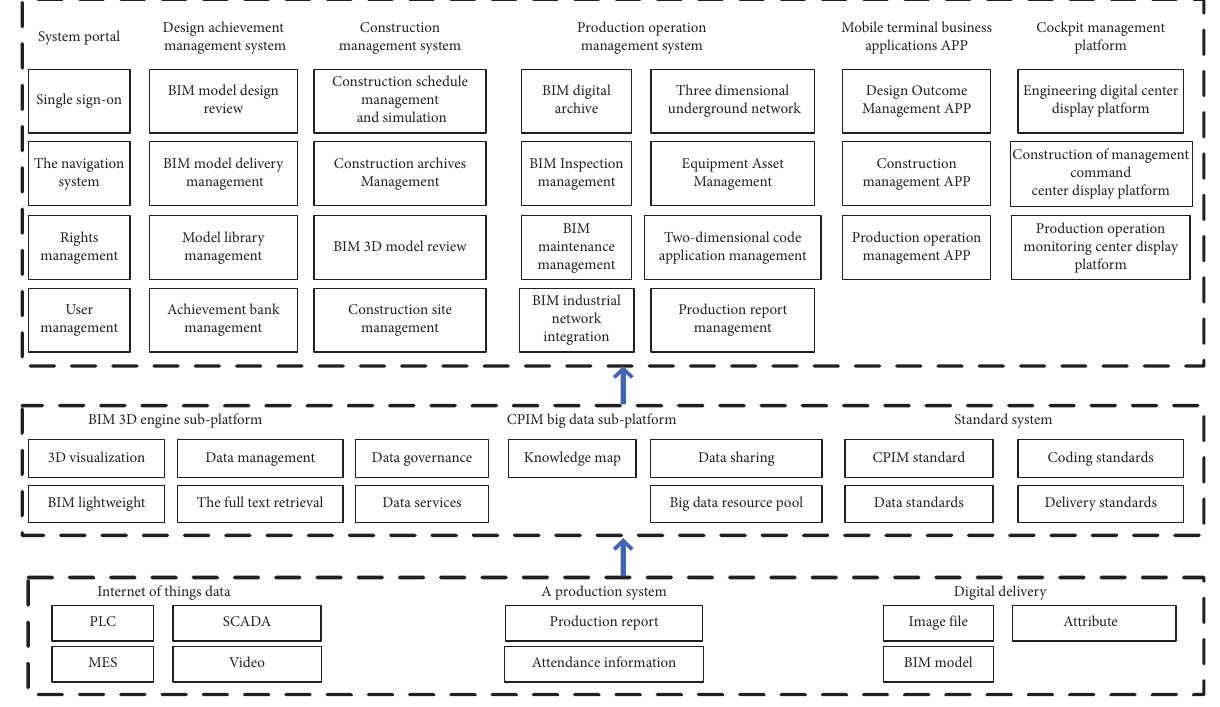
Figure 2: Application architecture